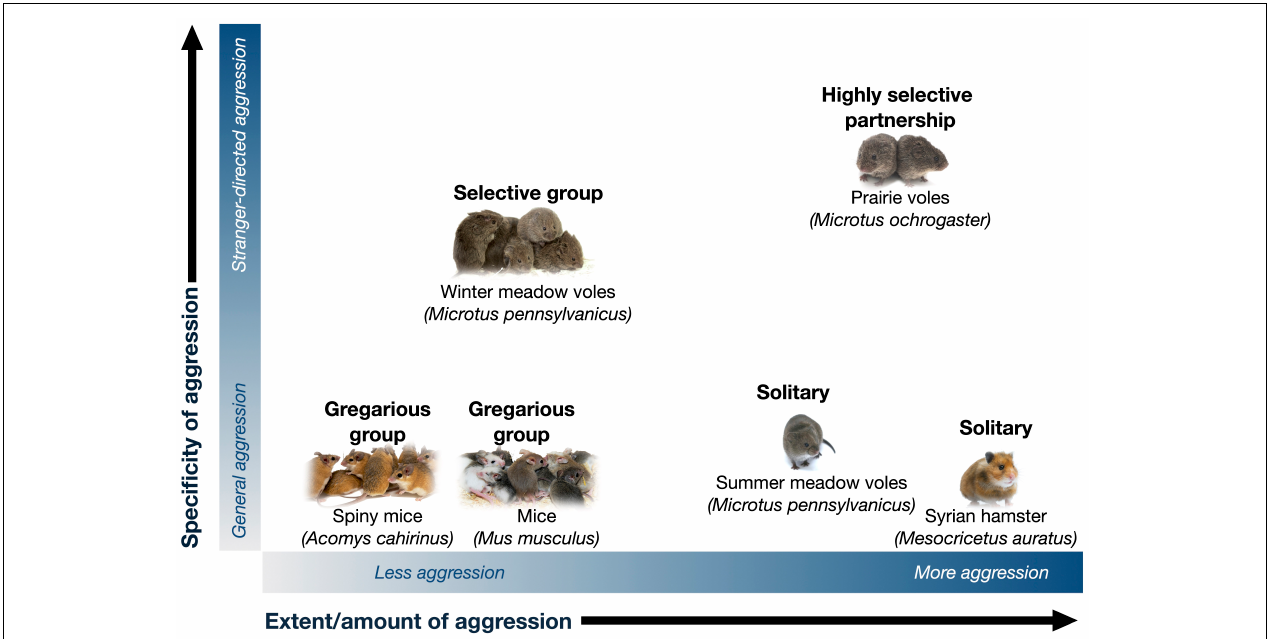
FIGURE 1 | Together with affiliation, aggression shapes the presence and nature of social groups. The vast majority of rodents are solitary, such as the Syrian hamster. Differences in the amount or extent of aggression ( x -axis) shape group formation, with low aggression and territoriality promoting gregarious group structures (e.g., mice, rats, and spiny mice) that may be flexible in size and composition. The generality vs. specificity ( y -axis) of how aggression is targeted shapes the selectivity of groups for specific known members. Selectivity may be maintained by “prosocial” factors such as motivation for social bonds, as well as by lack of aggression and intolerance toward group members vs. strangers. Highly selective species such as prairie voles exhibit both high levels of affiliation and stranger aggression, while less selective groups such as winter-phenotype meadow voles show preference for familiar individuals in the absence of social motivation or intense aggression. Photo credits: solitary rodent (Syrian hamster; The Rohit CC-BY NC 2.0), gregarious groups (Mice; Pixabay user Kapa65; Spiny mice; Aubrey Kelly by permission), selective groups (meadow voles and prairie voles; Beery Lab).